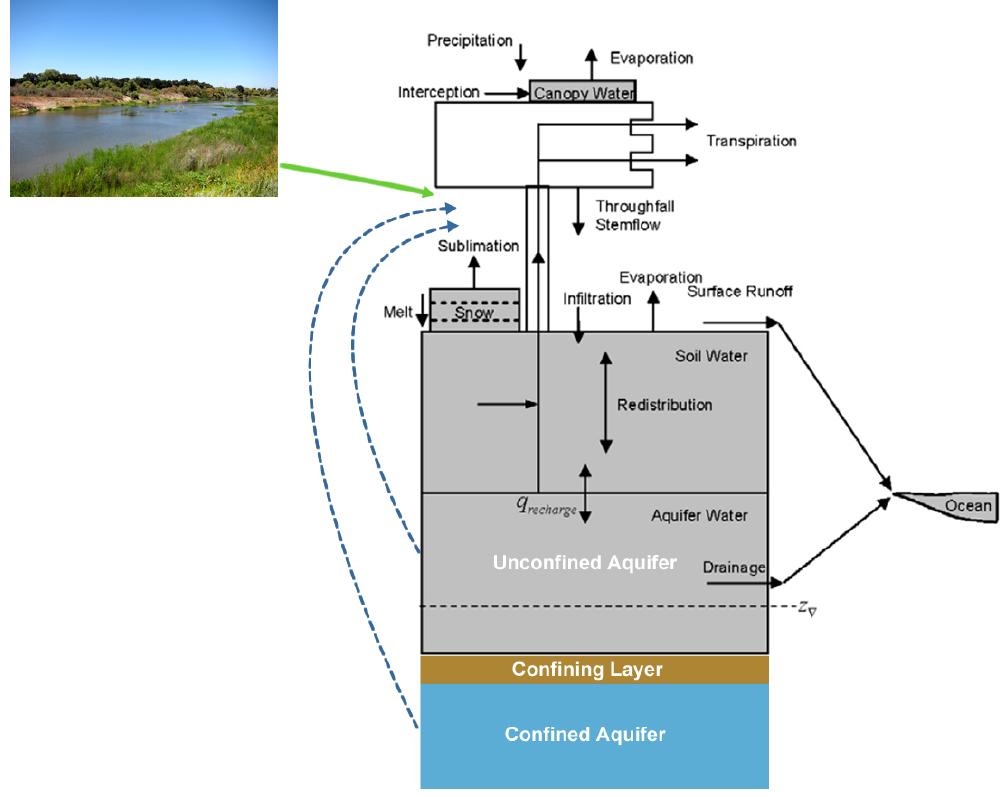
Figure 2. Conceptual schematic of land hydrological processes, modified from Oleson et al. (2008). Blue dashed and green lines indicate the irrigation water fluxes applied in the CLM. In the Central Valley, the aquifer is variably confined with some regions having no